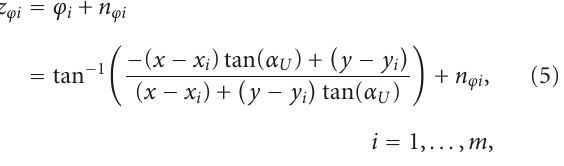
Assuming that the angle measurement noise n ϕi is IID (independent and identically distributed) white Gaussian , the FLAOA measurement noise with a variance of σ 2 ϕ equation considering the noise is written as z ϕi = ϕ i + n